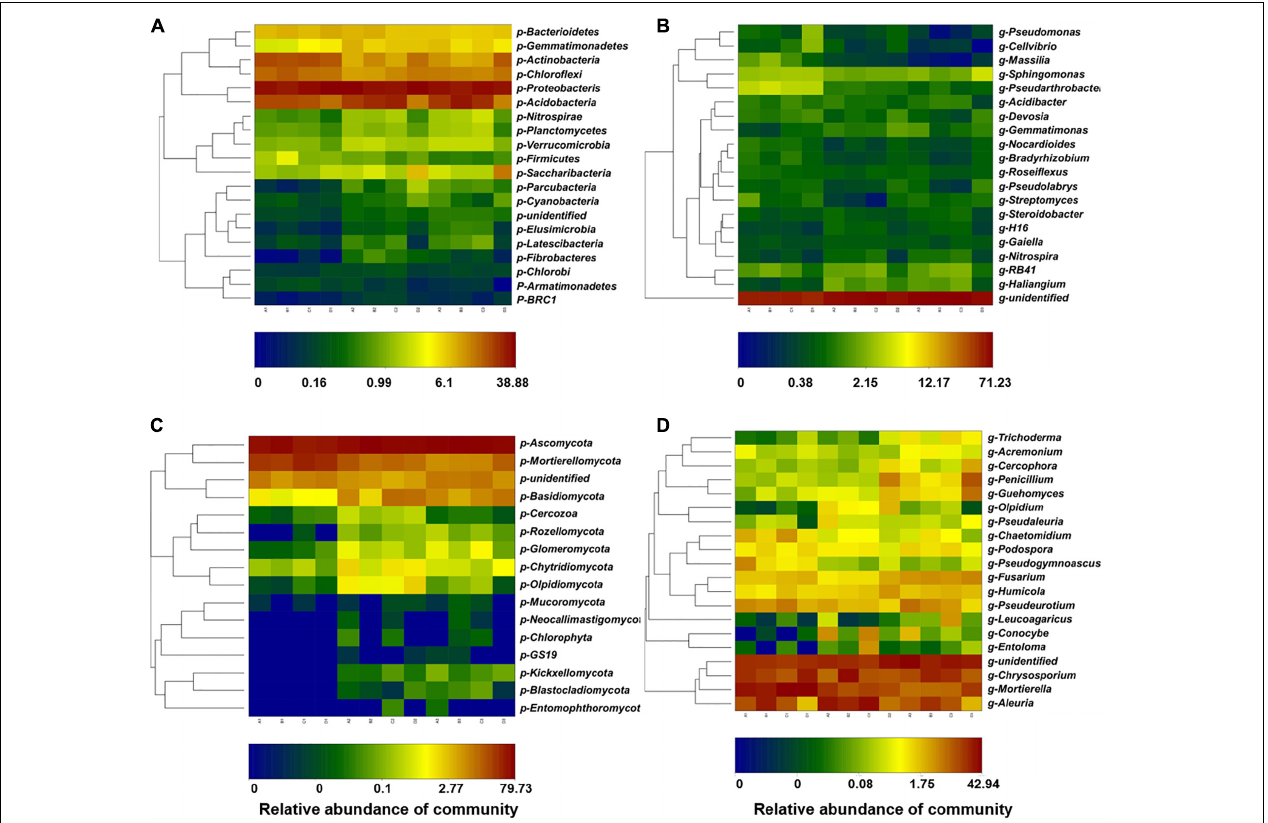
FIGURE 4 | Taxonomic profiles of the bacterial and fungal communities at the phylum and genus levels. The relative abundances of the top 20 bacterial phyla (A) and the top 20 bacterial genera (B) . The relative abundances of the top 20 fungal phyla (C) and the top 20 fungal genera (D) . A, non-treated control; B, soils treated with fenaminosulf; C, soils treated with kasugamycin; D, soils treated with dazomet. Numbers 1, 2, and 3 represent samples collected at 14, 55, and 110 days after soil treatment, respectively.